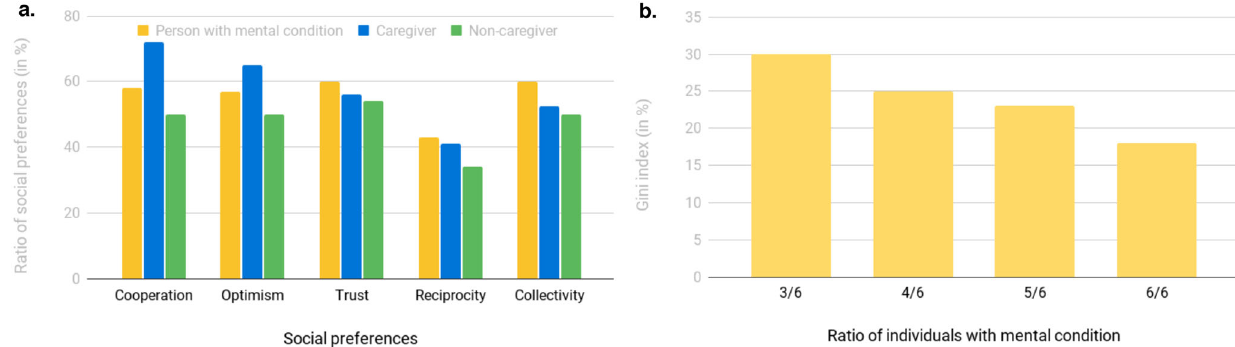
Fig. 4 Some relevant scienti fi c results of “ Games for Mental Health ” from Cigarini et al. (2018c). a Degree (in %) of each behavioural trait obtained with the different games. The results are aggregated depending on the participant ’ s role within the mental health care community. b Level of inequality (in %) within the group of participants, by the number of people with mental health conditions in a group playing the